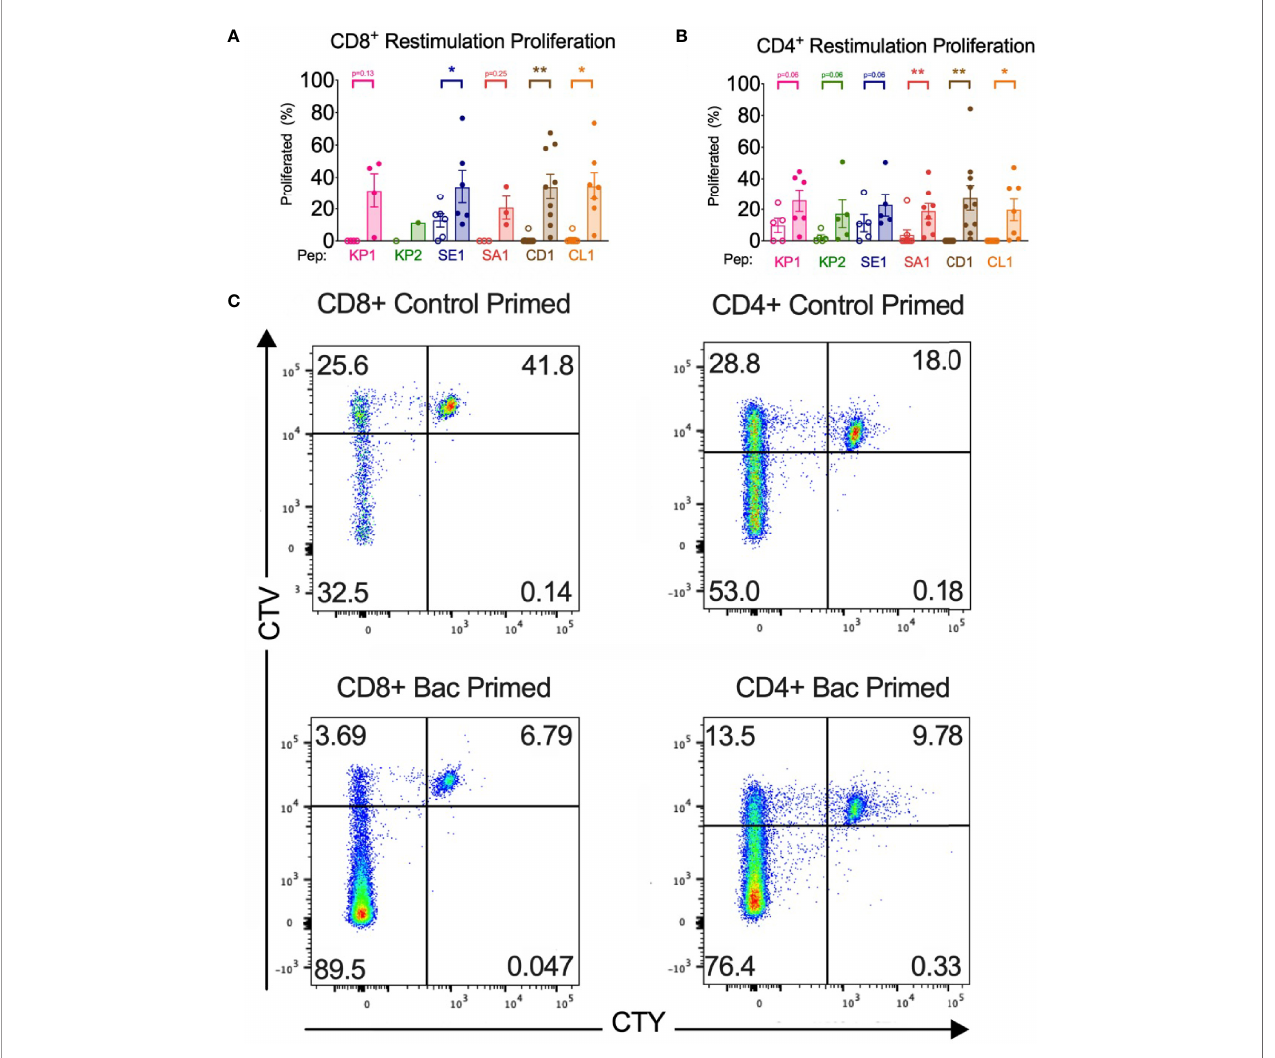
FIGURE 4 | Bacterial peptide priming increases T cell proliferation in responders. (A) CD8+ proliferation from restimulation is enhanced by pathogenic bacterial peptide priming ( n =1-10). (B) CD4+ proliferation from restimulation is enhanced by bacterial peptide priming ( n =5-10). Unshaded bars- Control-primed (irrelevant peptide, PVSKMRMATPLLMQA), then SARS-CoV-2-peptide restimulated. Shaded bars- bacterial peptide primed then SARS-CoV-2-peptide homologue restimulated. * P <0.05, ** P <0.01 by Wilcoxon-matched-pairs-signed rank test, comparing the magnitude of response to SARS-CoV-2 peptides with or without bacterial peptide priming after subtraction of the background control. (C) Representative CellTrace Yellow (CTY) vs. CellTrace Violet (CTV) dot plots of CD8+ and CD4+ cultured cells. Top right quadrant gate (CTY hi CTV hi cells) did not proliferate upon priming or restimulation. Top left quadrant gate (CTY lo CTV hi cells) proliferated upon priming but not with restimulation. Bottom left quadrant gate (CTY lo CTV lo cells) proliferated upon both priming and